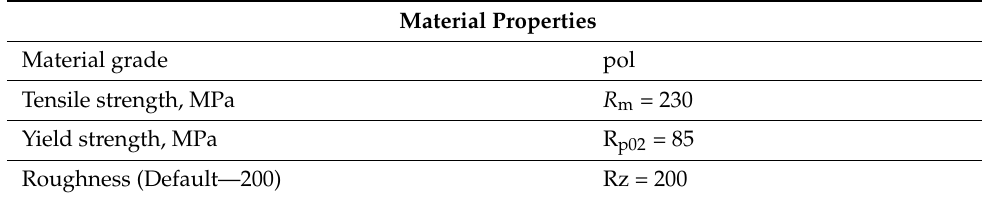
Table 11. Basic physical and mechanical properties of the Ni-7Cr-3Fe + 60% WC coating.